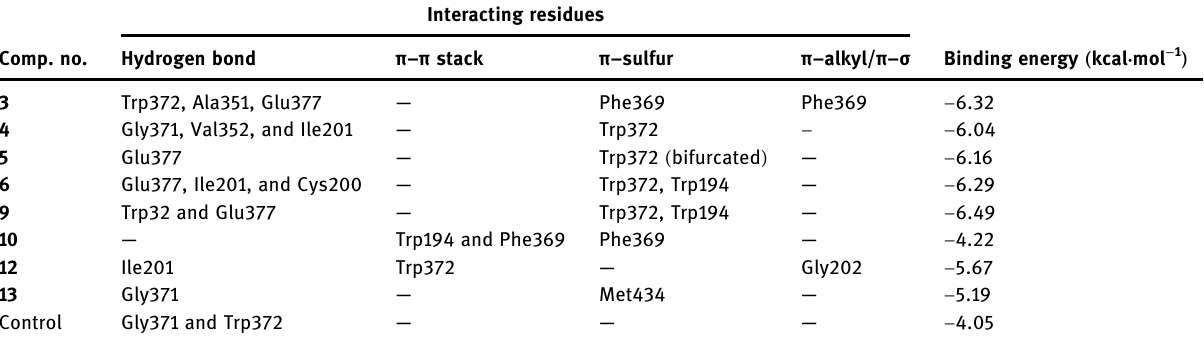
Table 2: Interacting residues and binding energy of the docked compounds in the binding site of iNOS ( PDB ID = 4NOS ) Interacting residues Comp.